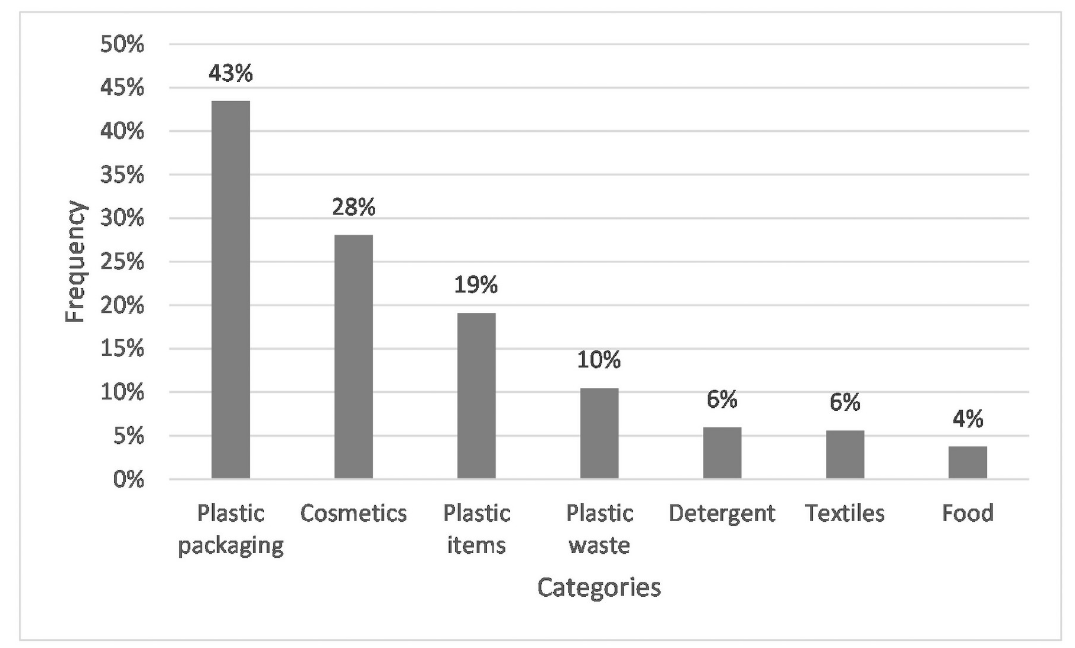
Fig 8. Frequencies of students whose answers assigned to the corresponding categories for Q3: “Name sources of microplastics in the household?” N = 267. Open question with categories formed from students’ answers.